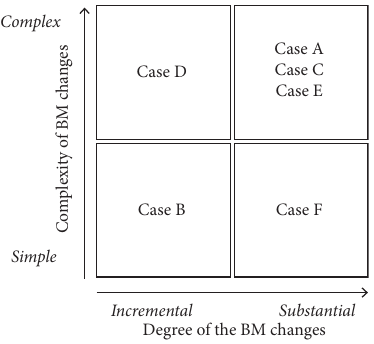
Figure 2. Complexity and degree of changes in the business model (BM) (source: created by